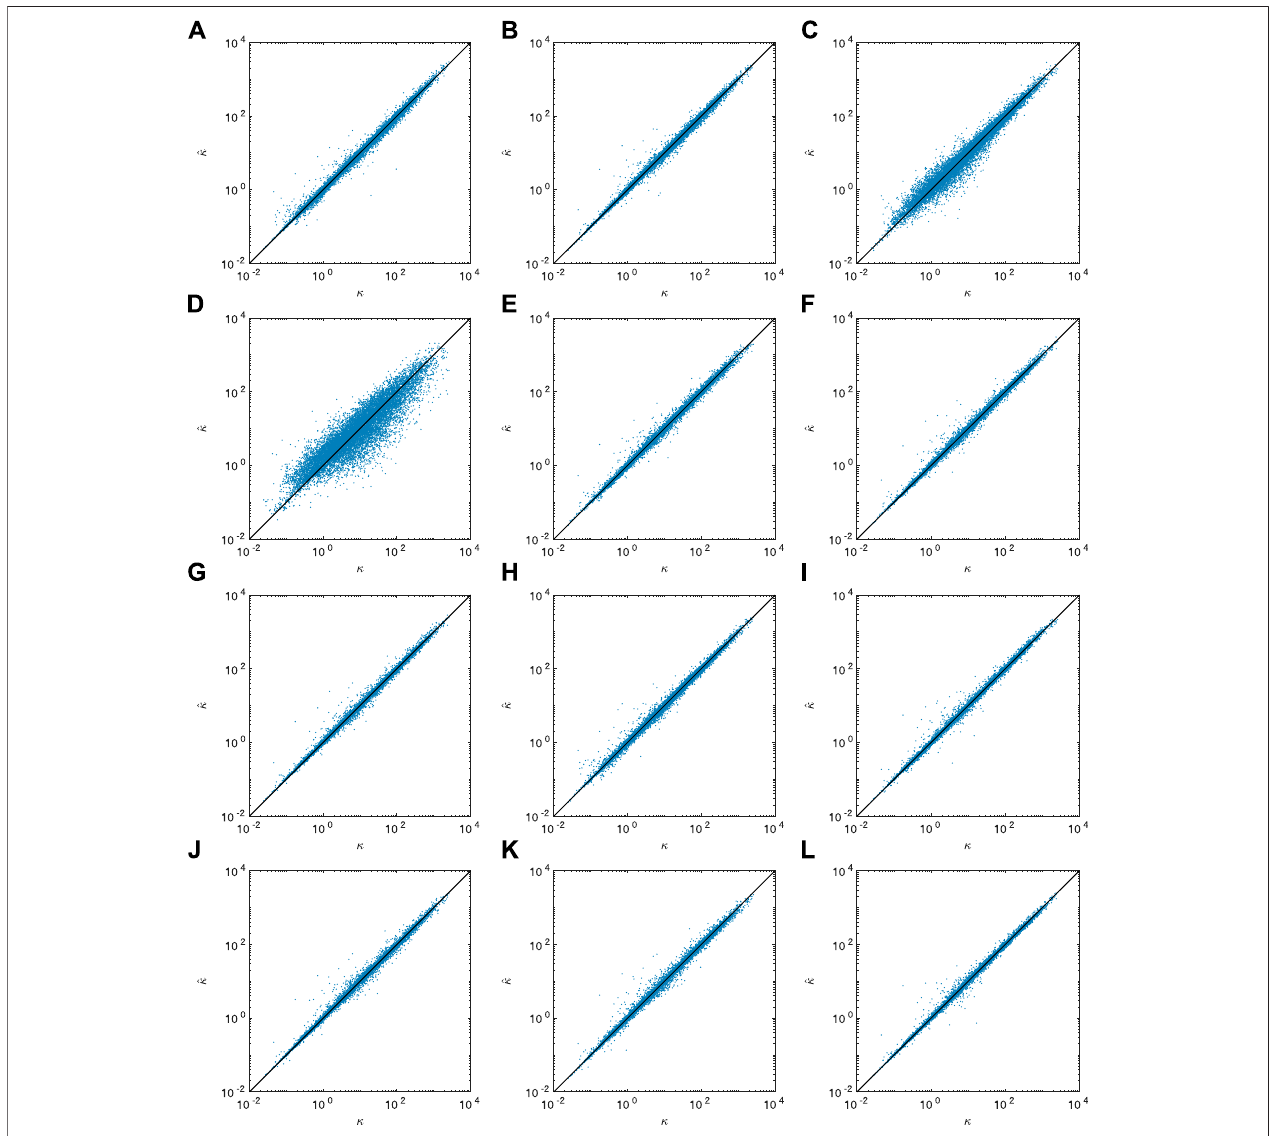
FIGURE6| PredictionofpermeabilityusingANNs.Toprow (fromlefttoright): Predictionof κ viaModels1 – 3.Secondrow (fromlefttoright): Predictionof κ via Models 4 – 6.Thirdrow (from left to right): Prediction of κ via Models7 – 9. Bottom row (from left to right): Predictionof κ via Models 10 – 12. Note thatthe scatter plots show results based on the test